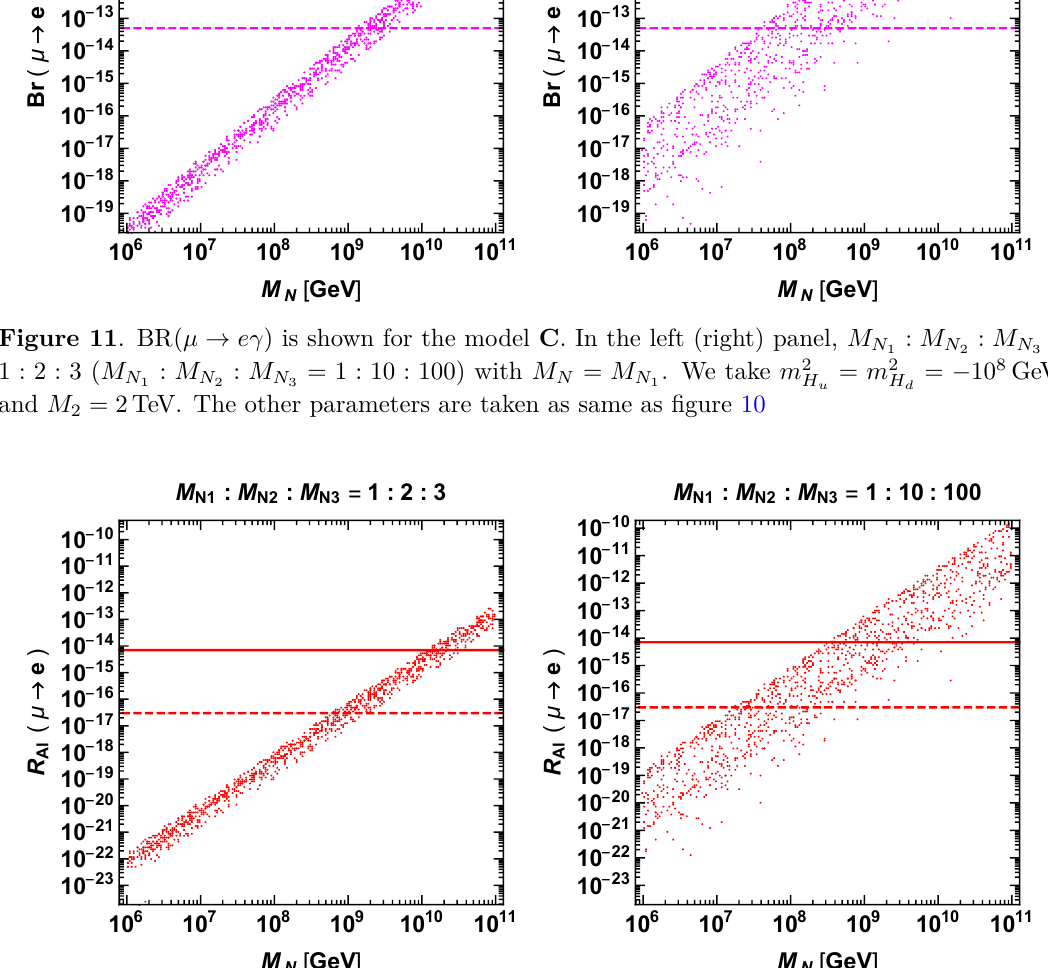
Figure 12 . R Al ( µ → e ) is shown for the model C . The parameters are same as figure 11.